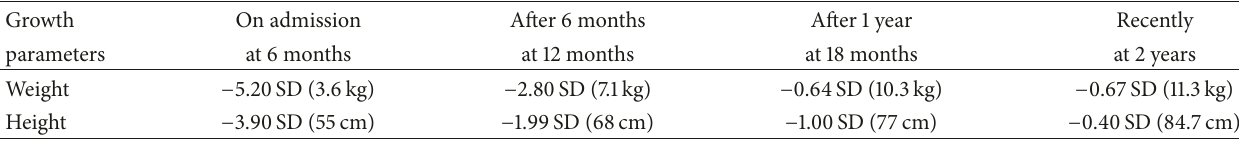
Table 1: Growth parameters progression.